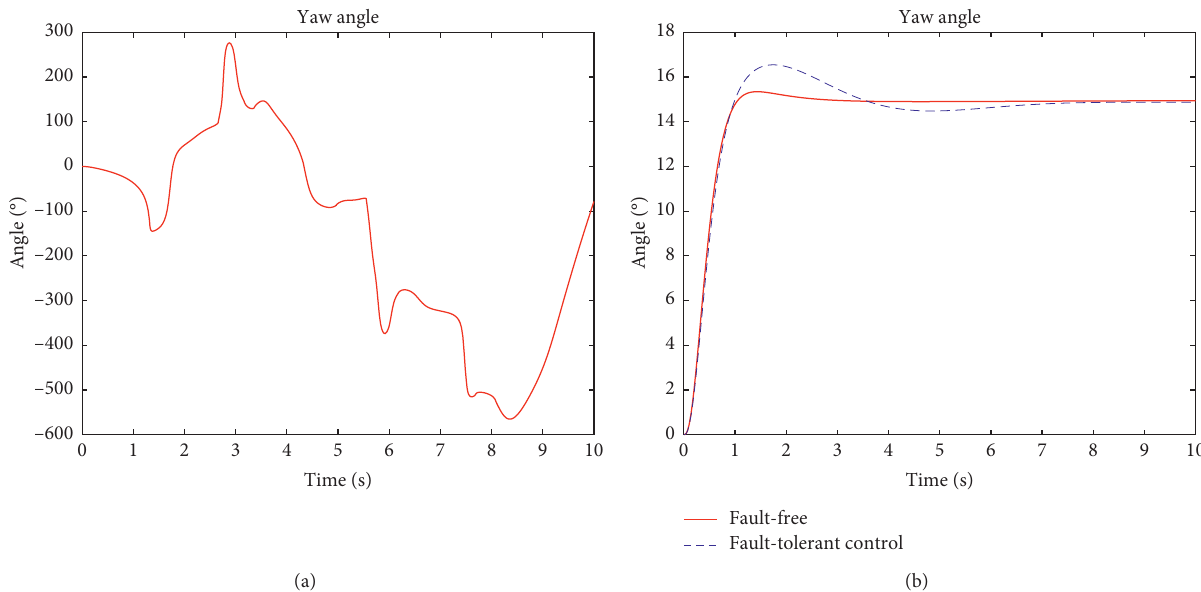
Figure 8: Comparison diagram of the yaw angle before and after fault-tolerant control. (a) Non-fault-tolerant control. (b) Fault-tolerant control.